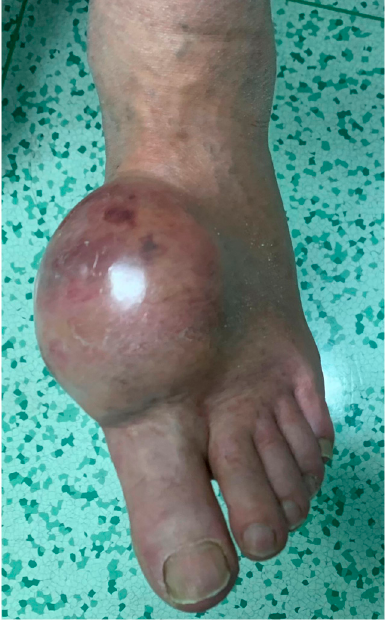
Figure 5. Clinical appearance of a large epithelioid sarcoma of the foot in a 55-year-old female pa-